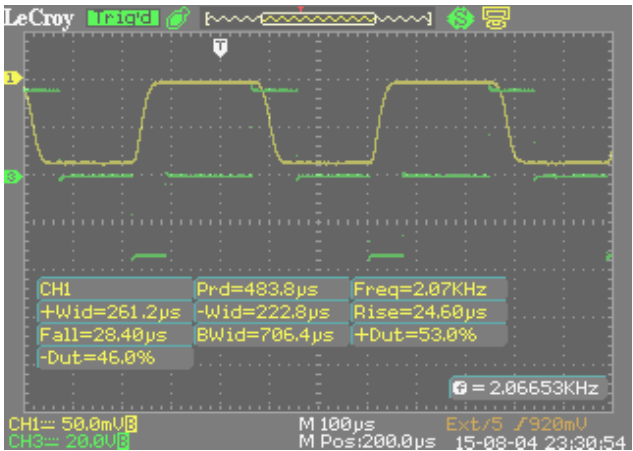
Figure 13. Oscillograms of the control voltage (zero level — digit 3) and optical response (zero level — digit 1) for the bistable switching mode. The upper level of the optical response is the scattering state, the lower level is the nonscattering state. The thickness of the FLC cell with the HF-32 composition is 13 μ m. Control voltage — bipolar pulses of ±35 V. The frequency of light modulation is 2 kHz.